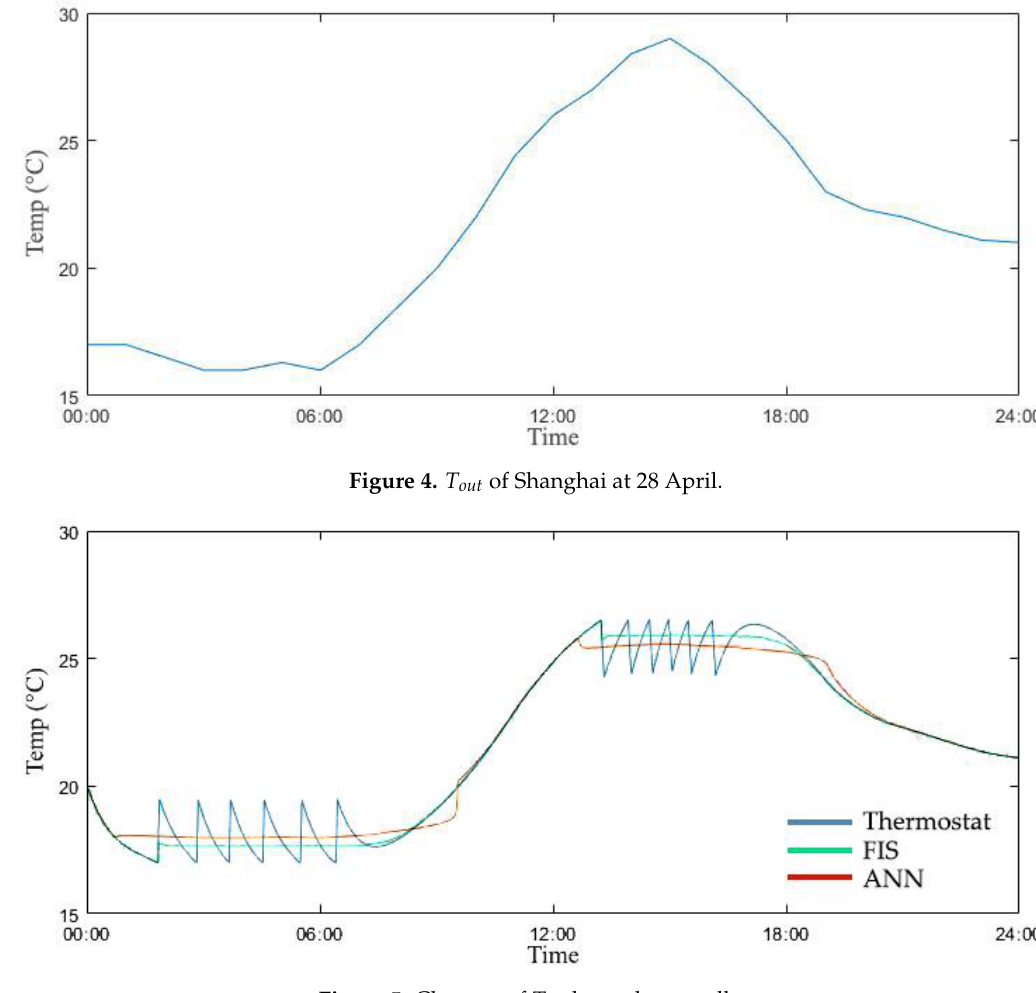
Figure 5. Changes of T rm by each controller.